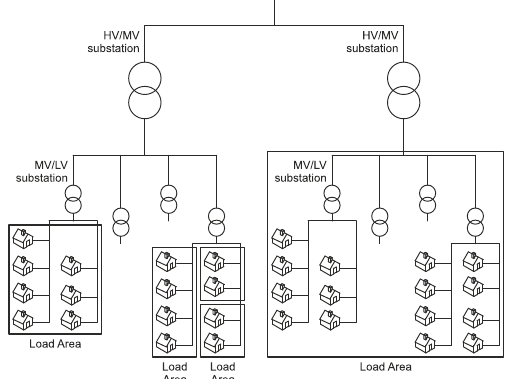
Figure 1. Possible Load Areas (LAs) in a distribution system [19].